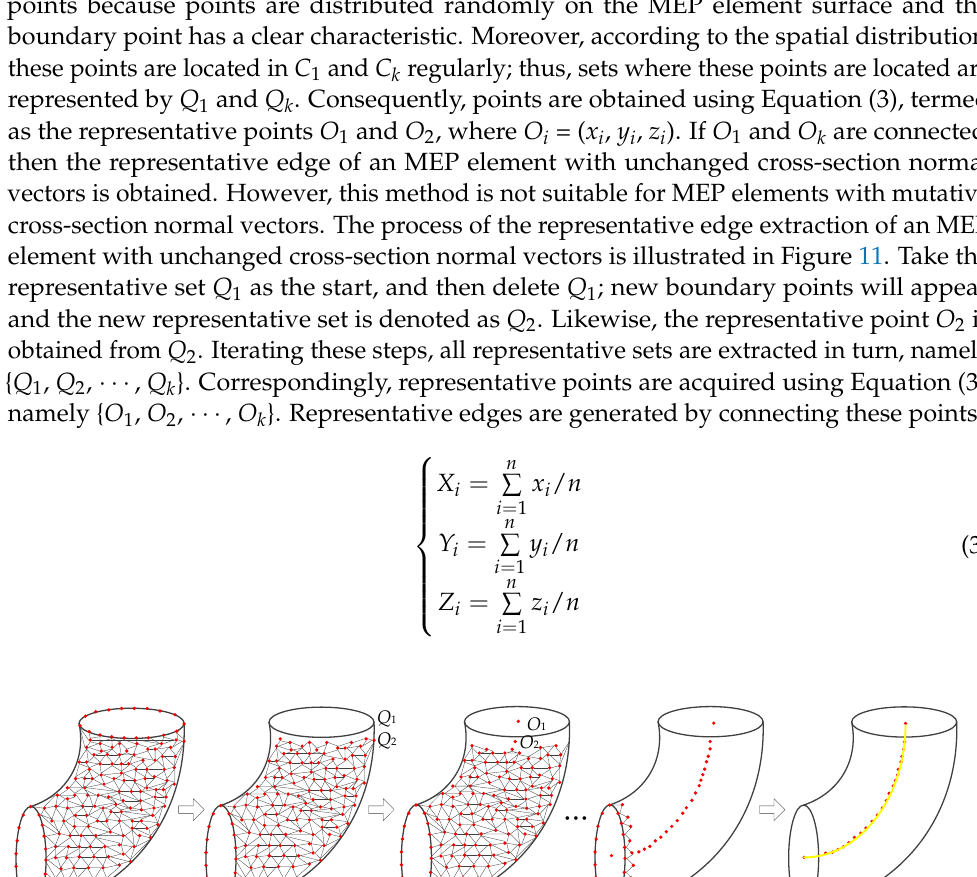
Figure 11. The process of representative edges extraction on a triangulated MEP element: ( a ) triangu- late an MEP element; ( b ) delete boundary points; ( c ) extract the center point of new boundary points; ( d ) extract all center points; ( e ) generate representative edges. Algorithm 1 summarizes the whole process of representative edge extraction from the MEP system. Line 3 acquires triangular meshes based on the Delaunay